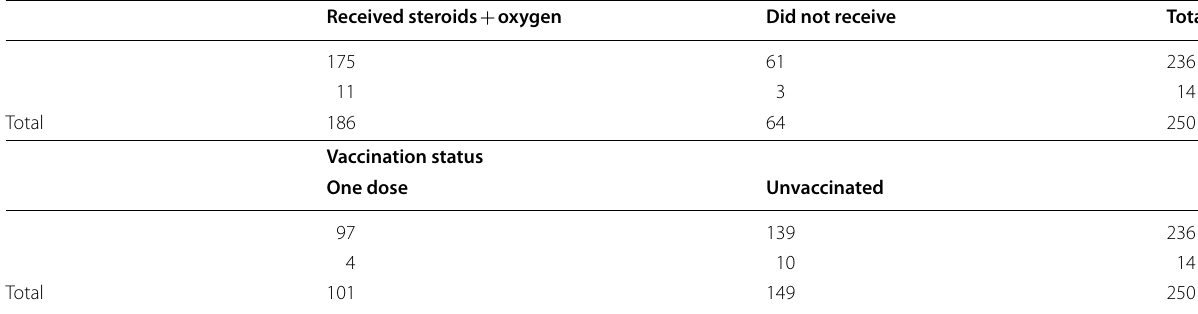
Table 2 Patient treatment